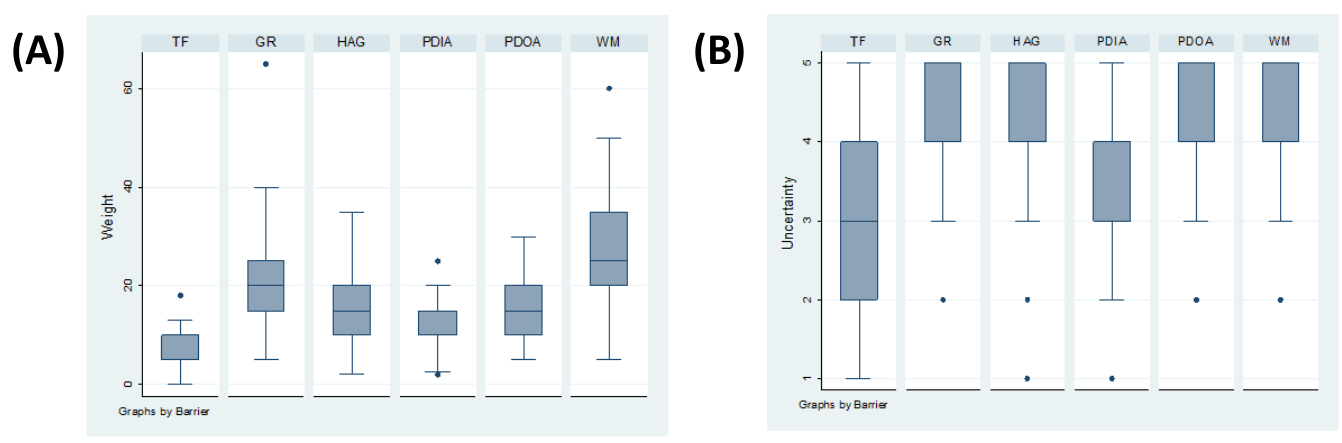
Figure 2. Expert opinion on the weight of the different barrier gestures ( a ) and their degree of certainty ( b ). TF: traffic flow, GR: greetings without contact, HAG: usage of hydro-alcoholic gel (hand sanitisation), PDIA: physical distancing inside the auditoriums, PDOA: physical distancing outside the auditoriums, WM: wearing a mask. The overall weighted score (OWS) obtained is 68.2, on a range from 0 to 100 (Figure 3 and Figure A1).